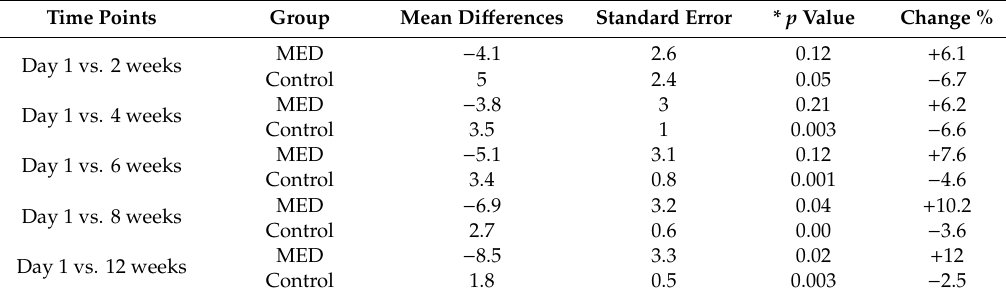
Figure 4. Box-plot with min–max values for the control (C) and test (MED) groups at 6 and 12 weeks using the Mann-Whitney test, * p < 0.05. Table 1. Results of the Bonferroni test for pairwise comparison of the mean implant stability at different time points in the MED and control groups (MD) .